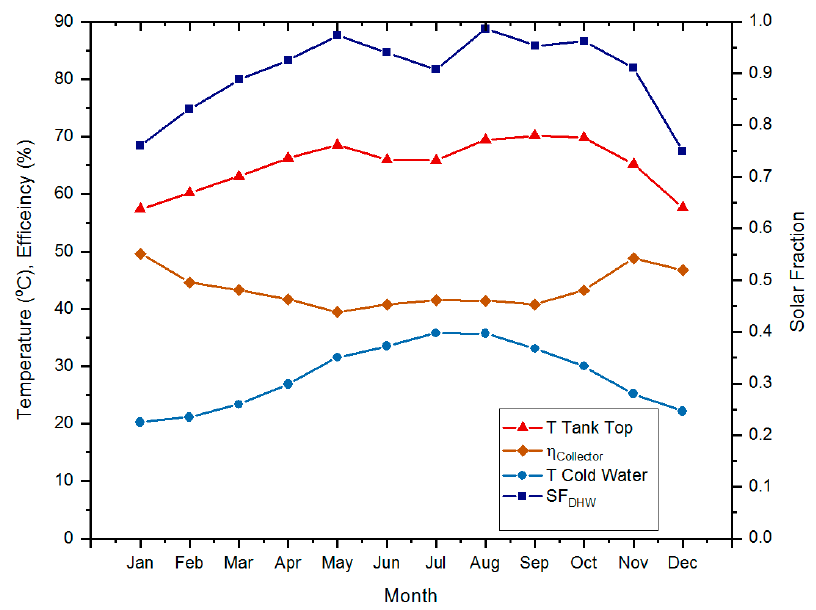
Figure 20. Annual simulation of typical SDHW system in UAE.